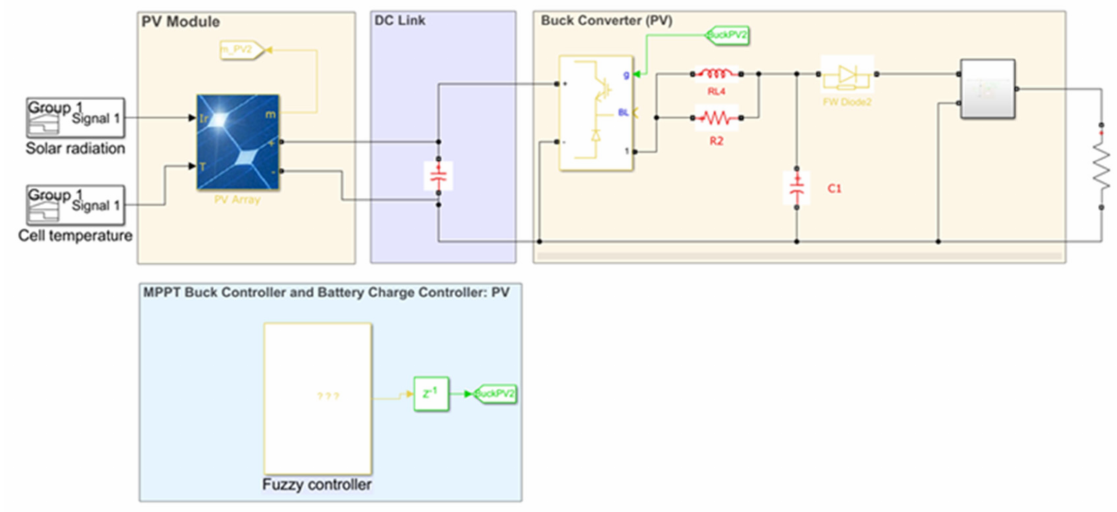
Figure 4. PV Simulink